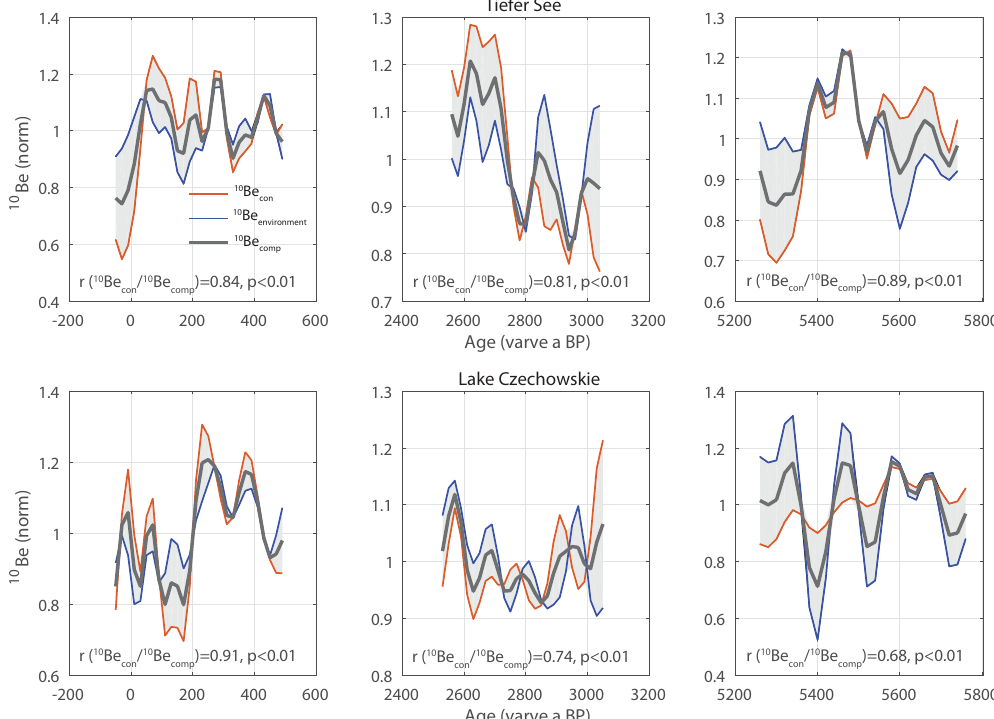
Figure 4. Tiefer See (TSK) and Lake Czechowskie (JC) 10 Be concentration ( 10 Be con ), corrected 10 Be ( 10 Be environment ) and 10 Be composite ( 10 Be comp ) time series around the Maunder, Homeric and 5500aBP grand solar minima. All time series are resampled to a 20-year resolution and normalized by dividing by the mean. A 75-year low pass filtered was applied to reduce noise. Uncertainty ranges of 10 Be comp (gray shadings) are expressed as the differences between the 10 Be con and 10 Be environment time series. Significance levels of correlations between 10 Be 10 Be con and comp were calculated using a random phase test (Ebisuzaki,